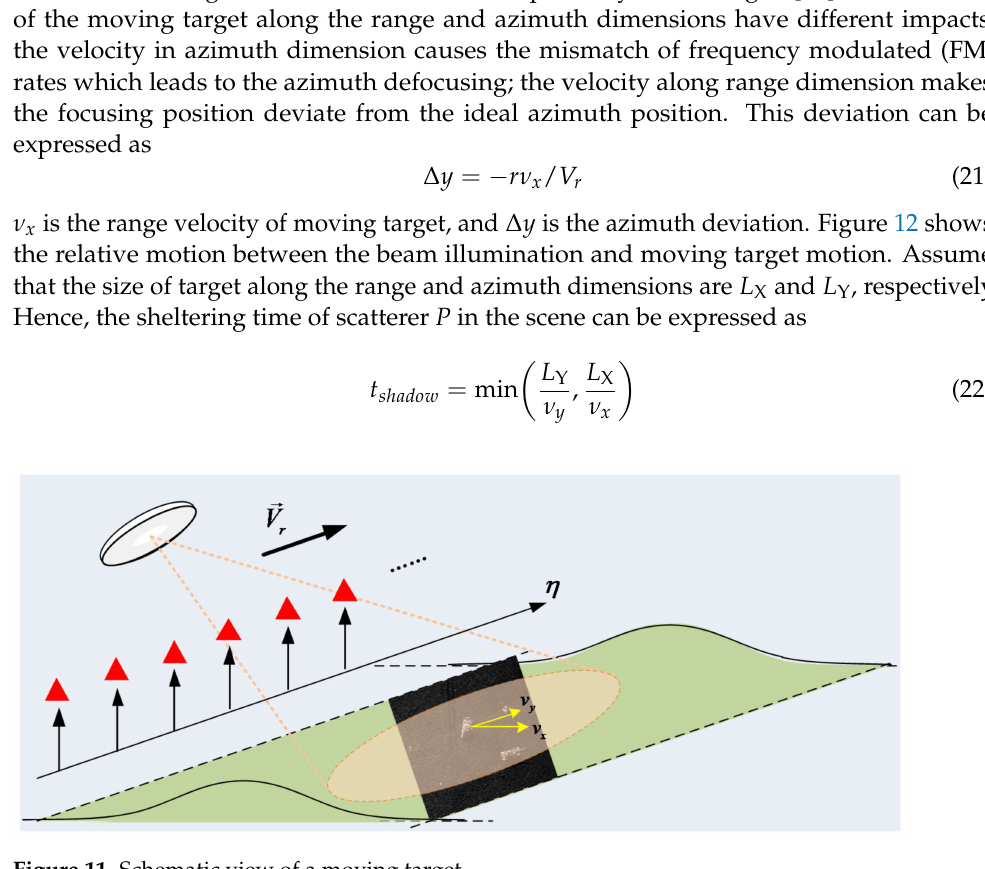
Figure 11. Schematic view of a moving